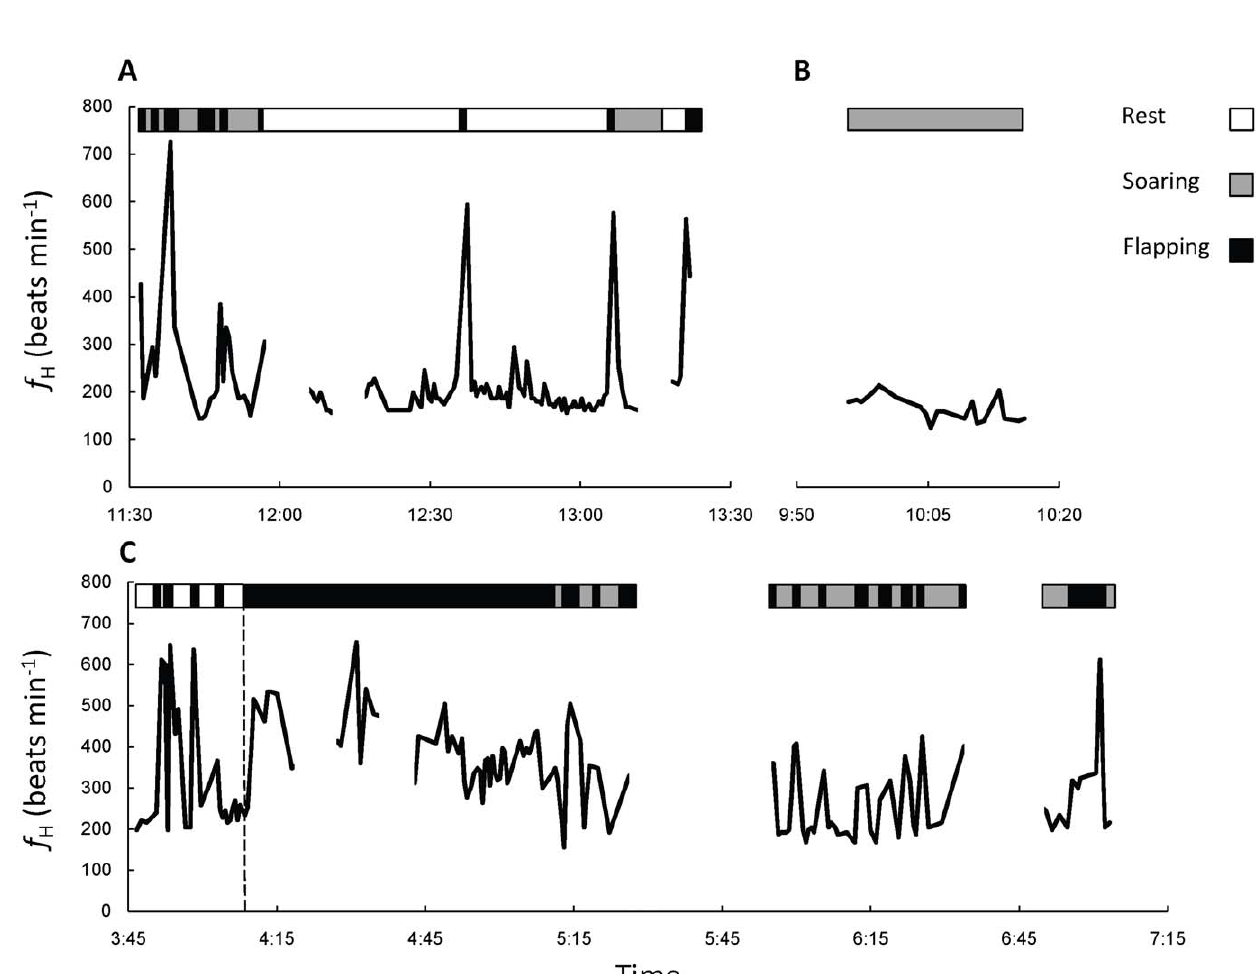
Figure 6. Heart beat frequency ( f H ) traces of two European bee-eaters engaged in different activities during stopover and cross- country flight. (A) f H of bird no. C48417 during stopover on May 5 2006 in relation to bird activity. A sample of this data can be heard in Audio S2. (B) f H of the same bird on the following day, 6 May 2006, during cross-country flight. A sample of this data can be heard in Audio S1. (C) f H of bird no. CC30955 on May 25 2006. The bird was followed during stopover in the early morning and then took off (dashed vertical line) for cross-country flight in which it was followed for a distance of 90 km from the stopover site until its signal was lost. Time is GMT; add two hours for local time.